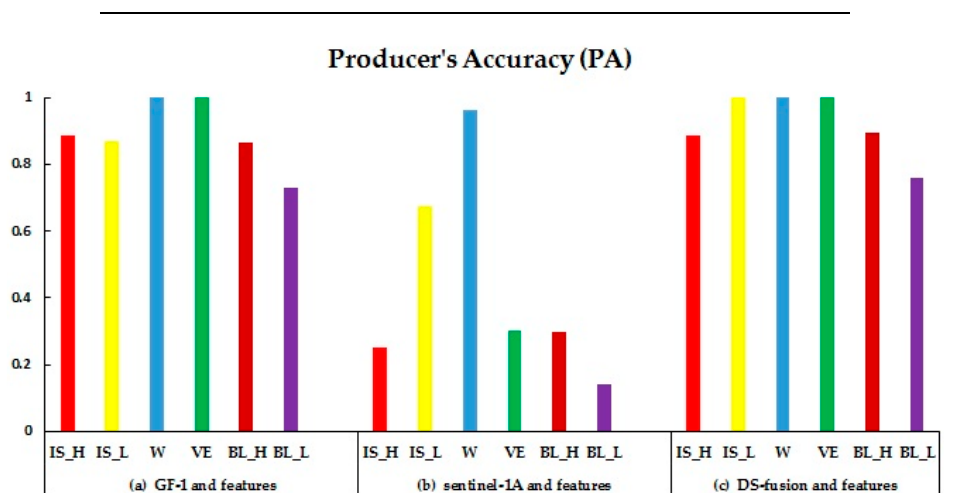
Figure 9. The producer’s accuracy of land cover types extracted from different data sources. ( a ) The producer’s accuracy of land cover types extracted from GF-1 image and features; ( b ) The producer’s accuracy of land cover types extracted from Sentinel-1A image and features; ( c ) The producer’s accuracy of land cover types extracted from fusing the GF-1 and Sentinel-1A images with features.